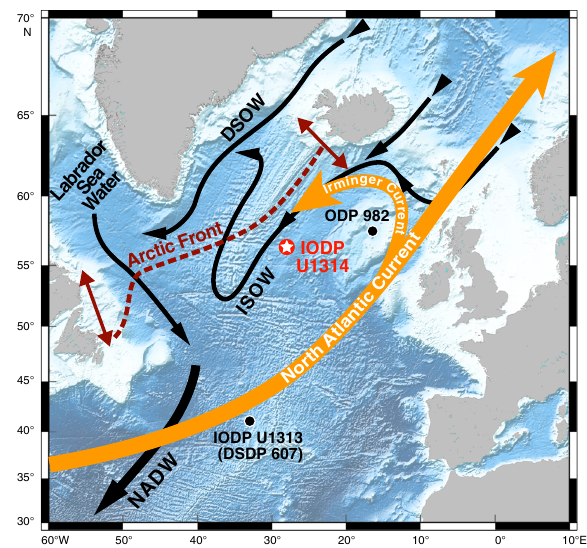
Fig. 1 Oceanographic setting of the subpolar North Atlantic. Major ocean currents and locations of this study (IODP Site U1314, 56°21.9 ′ N, 27°53.3 ′ W, water depth 2820m) and additional deep-sea drilling sites (IODP Site U1313, Deep Sea Drilling Project [DSDP] Site 607, and Ocean Drilling Program [ODP] Site 982) discussed in the text are shown. Brown arrows denote interglacial movement of the Arctic Front 30